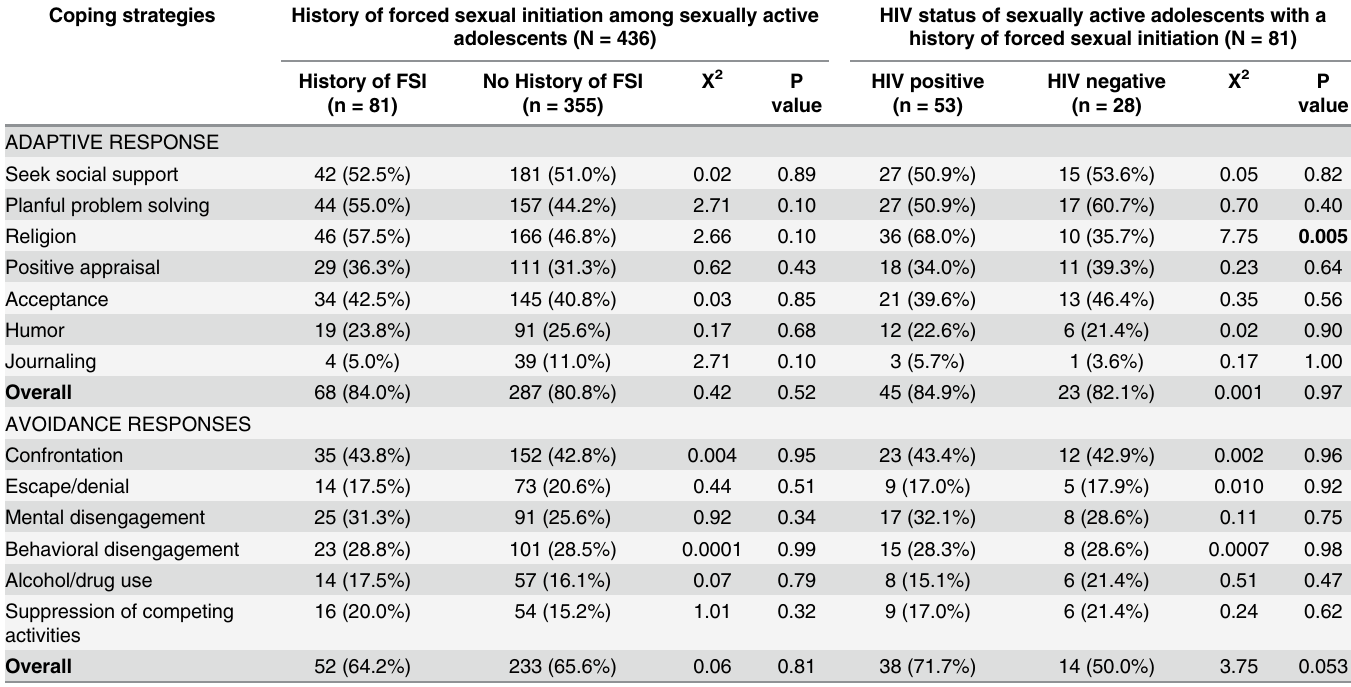
Table 4. Reported use of coping strategies by history of forced sexual initiation and self-reported HIV status. Coping